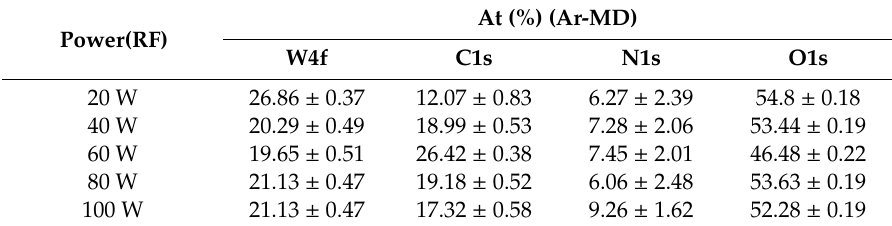
Table 2. Atomic concentrations of the obtained particles in Ar-MD configuration.